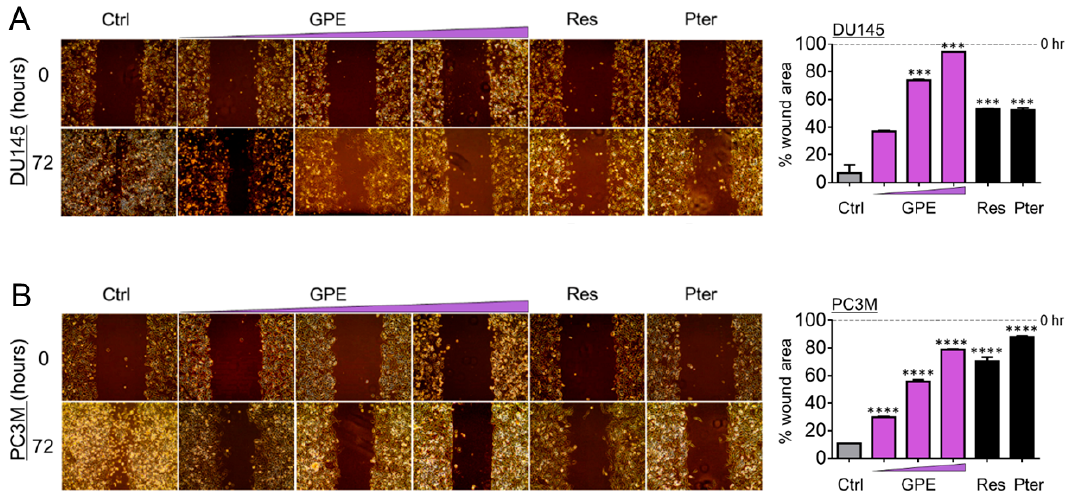
Figure 3. GPE reduces migration of DU145 and PC3M prostate cancer cells. Representative images of migration ability of ( A ) DU145 and ( B ) PC3M cells after treatment with GPE (1.5; 15; 100 µ g/mL) and Res and Pter (1.5 µ g/mL). Right: quantitation of wound widths, as % wound area is shown for each cell line. Data represent the mean ± SEM of six separate wounds and three independent experiments.